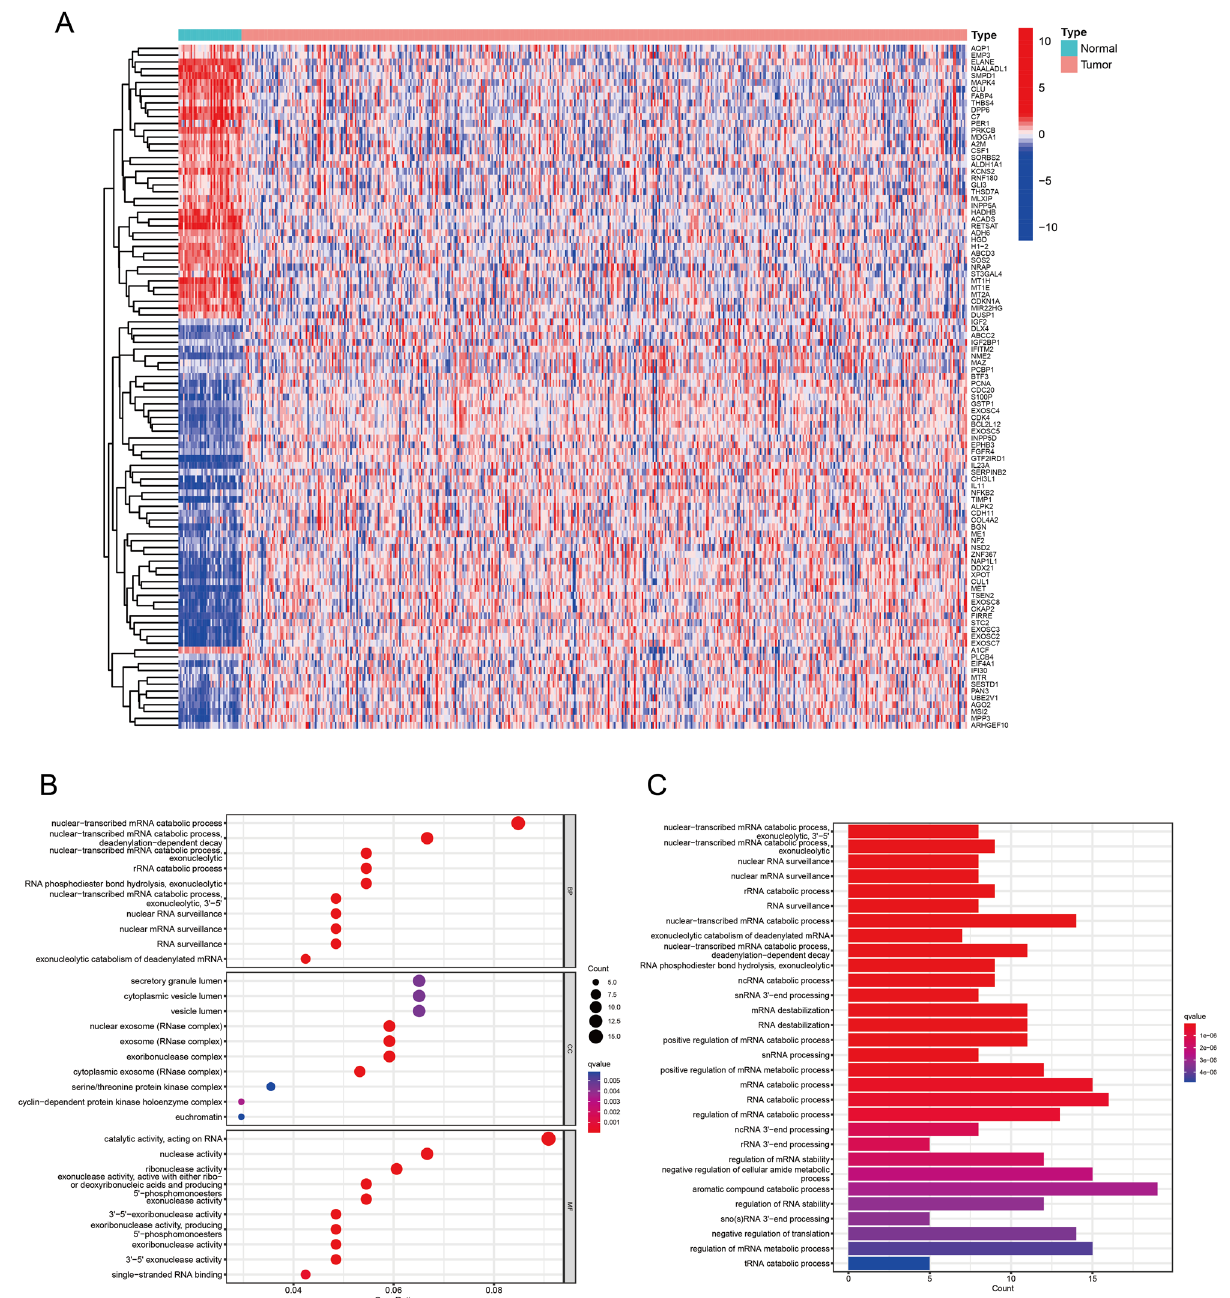
Figure 1. Analysis of differentially expressed butyrate metabolism-related genes. ( A ) Heatmap of differentially expressed butyrate metabolism-related genes. ( B ) GO analysis of differentially expressed butyrate metabolism- related genes. ( C ) KEGG analysis of differentially expressed butyrate metabolism-related differential